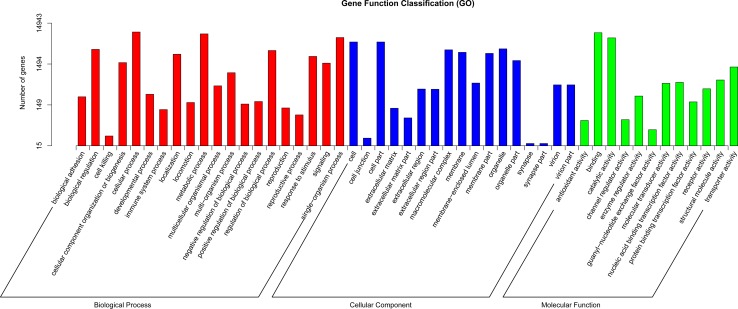
GO classifications of unigenes.